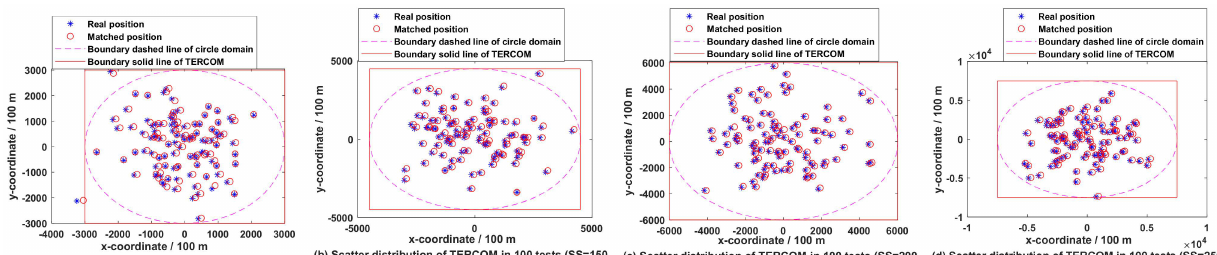
Figure 6. Matching scatter distribution of TERCOM under different sampling